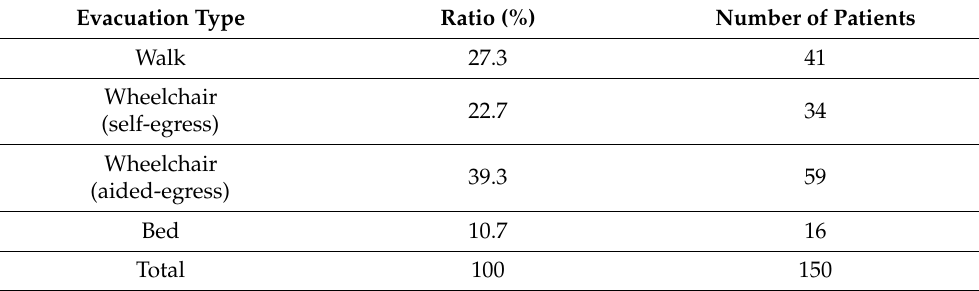
Table 4. Number of patients according to egress